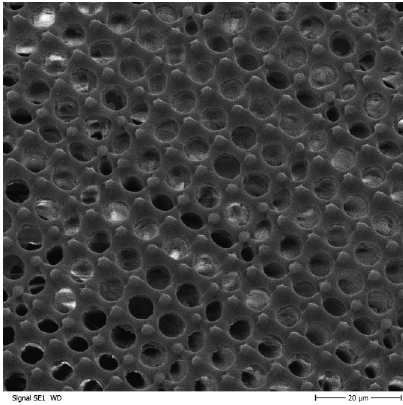
Figure 10. Structure with 35x35x35 microcells overview (0.28mm side length)